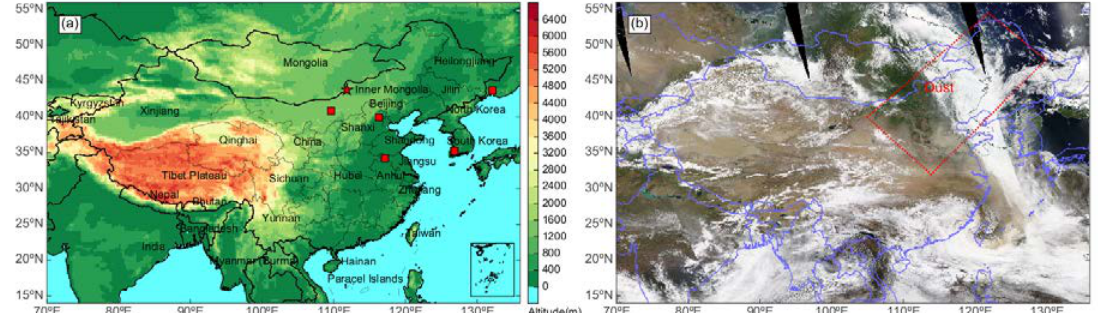
Figure 1. ( a ) Distribution of AERONET ( red squares ) and Lidar ( red stars ) stations. ( b ) MODIS-TERRA true color satellite cloud images on 4 May 2017.